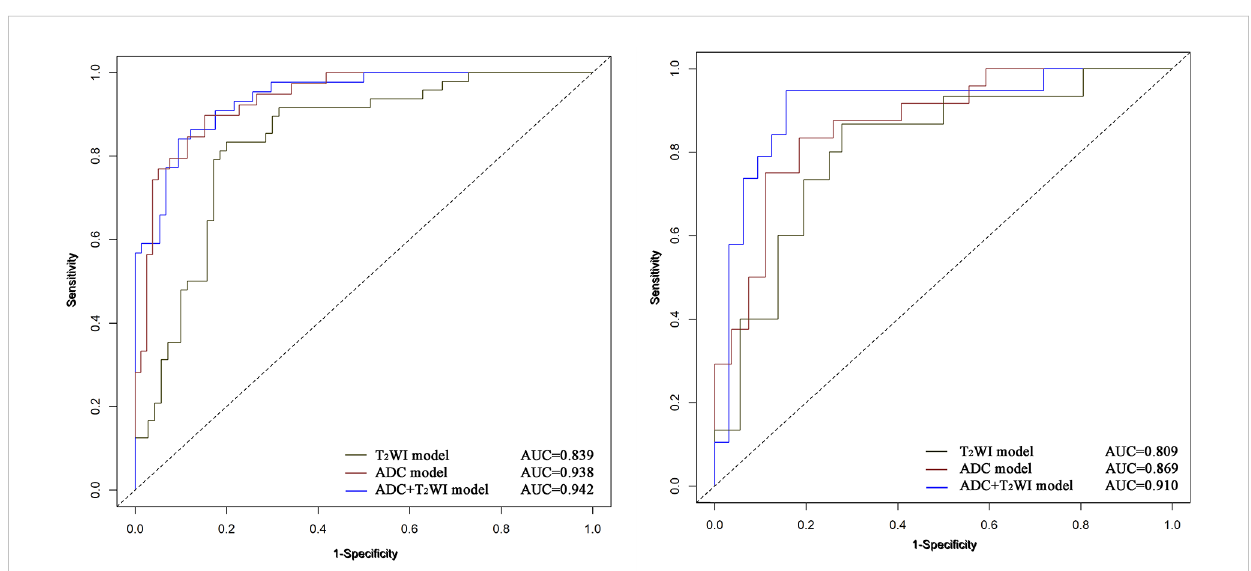
FIGURE 6 The nomogram integrating the radiomics score and independent risk factors was constructed to predict the pathological grade of